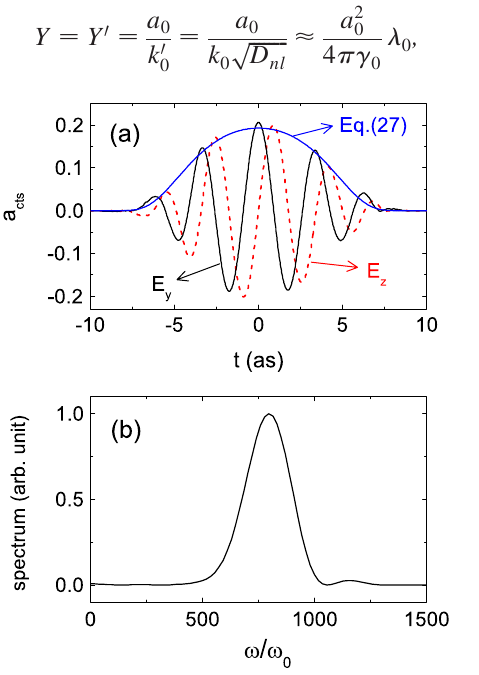
FIG. 4. Schematic drawings for electrons ð (cid:1) 0 ; p 0 Þ , incident waves ð a 0 :(cid:6) 0 Þ , and backscattered waves (CTS) before interaction and during CTS in both lab (a) and boosted (b)